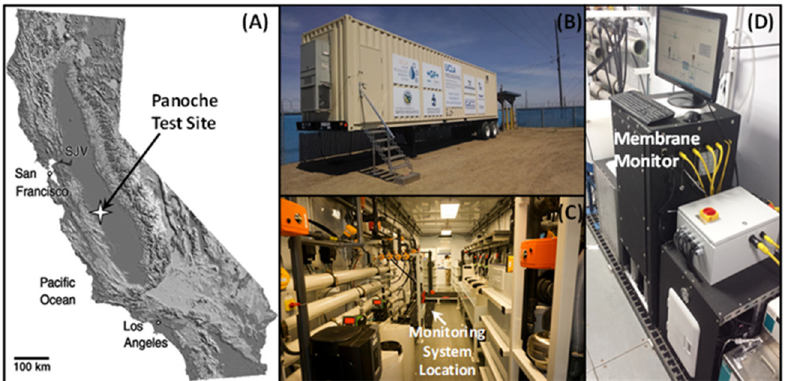
Figure 1. ( A ) Location of field-testing site in the San Joaquin Valley of California (adapted from [30]). ( B ) External view of the containerized RO plant. ( C ) Internal view of the RO plant. ( D ) Membrane monitoring system (MMS) inside the RO plant trailer.